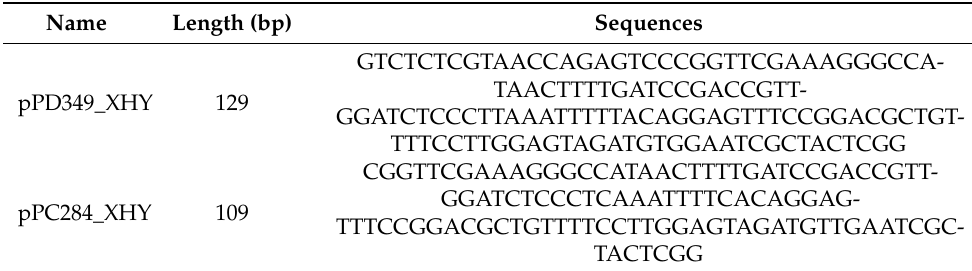
Table 1. Information of two candidate repeats in P. xiaohei .